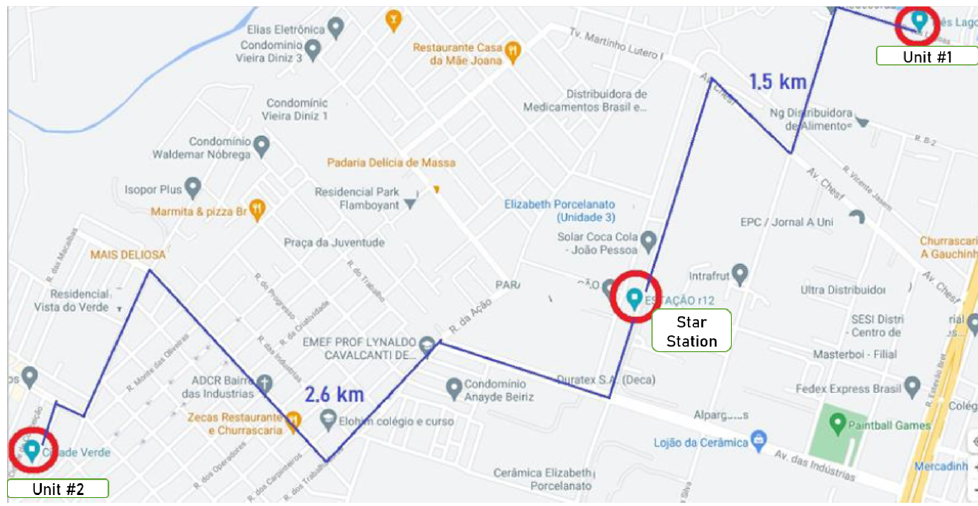
Figure 3. Map of the water supply network. Adapted from Google Maps